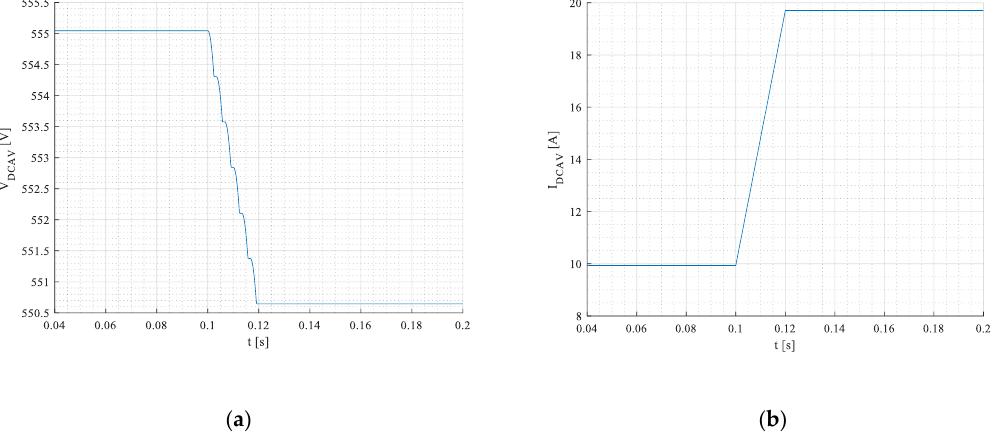
Figure 15. Voltage ( a ) and current ( b ) on the DC side of a rectifier, under step change of resistive load. Apparent, active, blind, and distorted power components during the transient state are shown at the end of the Section 3.2.